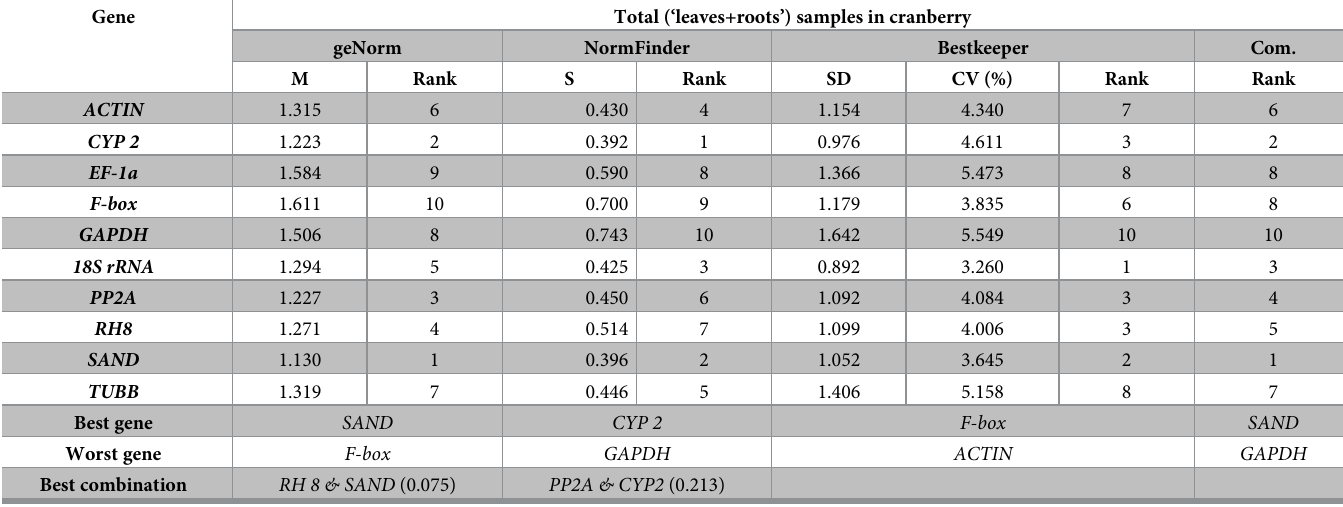
Table 6. Rankings of candidate reference 10 candidate reference genes in Total (‘leaves+roots’) samples treated by three stresses, using the geNorm, NormFinder and BestKeeper algorithms.